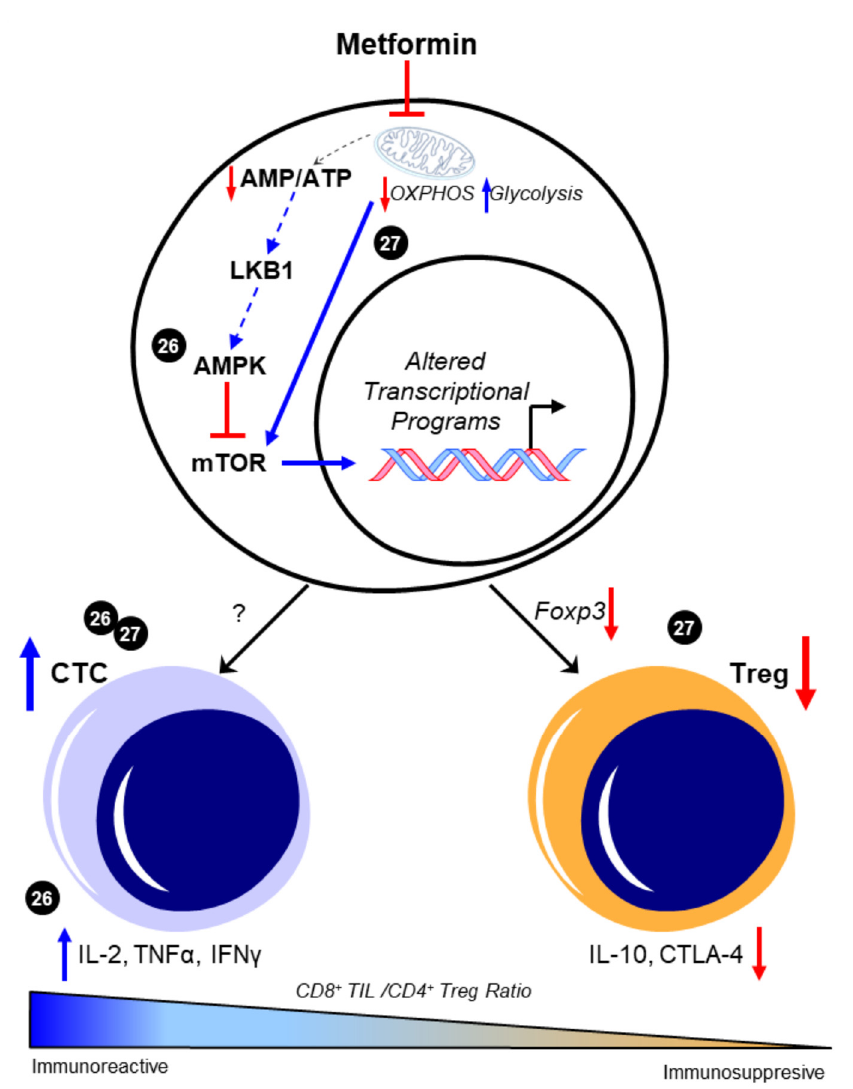
Figure 1. Metformin enhances CD8 + /CD4 + ratio to favor an immunoreactive microenvironment. The canonical pathway of metformin intracellular activity that results in 5 ′ -AMP-activated protein kinase (AMPK)-dependent inhibition of the mammalian target of rapamycin (mTOR) is shown. Presumably, this enhancement in AMPK and the consequent mTOR inhibition is attributed to the metabolic effects of metformin in promoting glycolysis through inhibited mitochondrial respiration; however, this was not experimentally shown in these studies and is represented by dotted lines. The ability of metformin to increase the CD8 + /CD4 + ratio [26,27] was associated with increases in functional CD8 + tumor-infiltrating lymphocytes (TILs) and concomitant increases in interleukin 2 (IL-2), tumor necrosis factor alpha (TNF α ), and interferon gamma (IFN γ ) [26]. Decreases in Foxp3-driven CD4 + T cell phenotypes and the subsequent reduction in interleukin 10 (IL-10) and cytotoxic T lymphocyte antigen-4 (CTLA-4) expression were also separately observed [27]. Cited experiments are denoted by their respective reference numbers [26,27]. CTC: cytotoxic CD8 + TILs, OXPHOS: oxidative phosphorylation, Treg: regulatory T cells. Blue arrows indicate upregulation/activation, red arrows indicate downregulation/inactivation and red T symbols indicate direct inhibition. Solid lines represent data presented in the cited manuscript; dotted lines indicate informed interactions from well-established